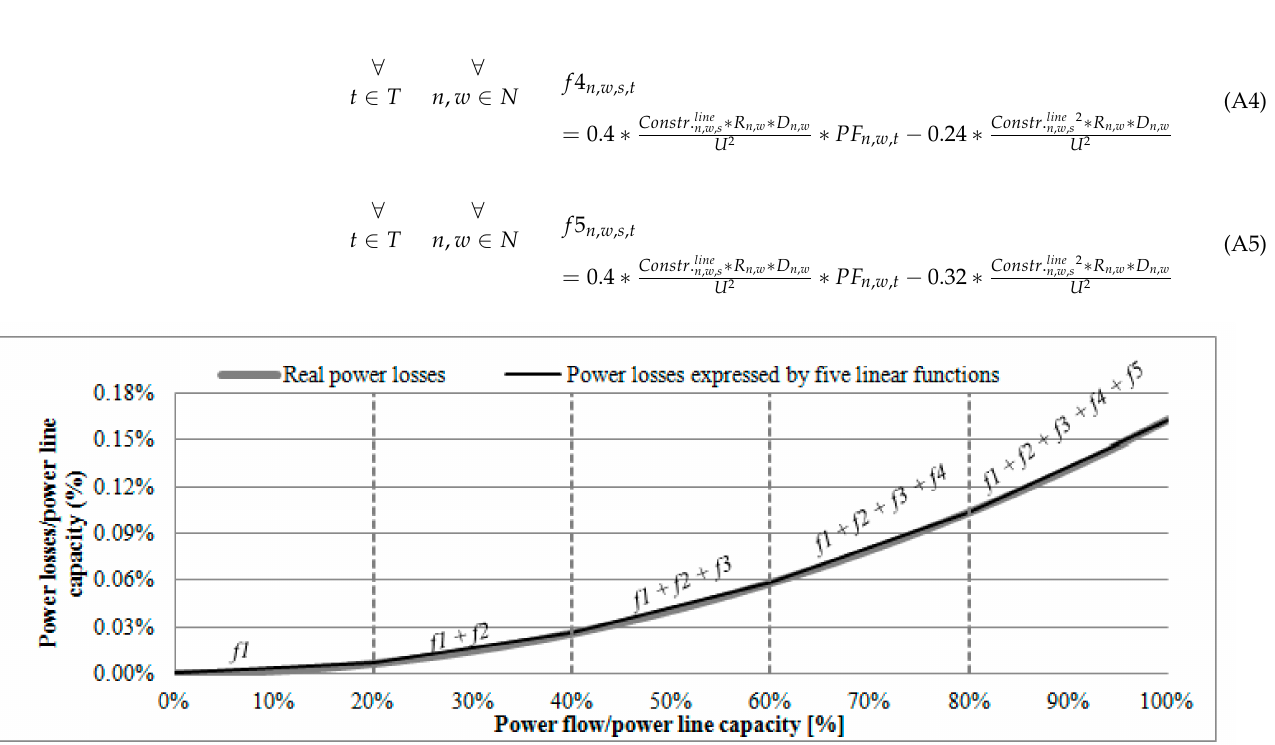
Figure A1. Power losses linearization—spline function consisting of five linear functions.